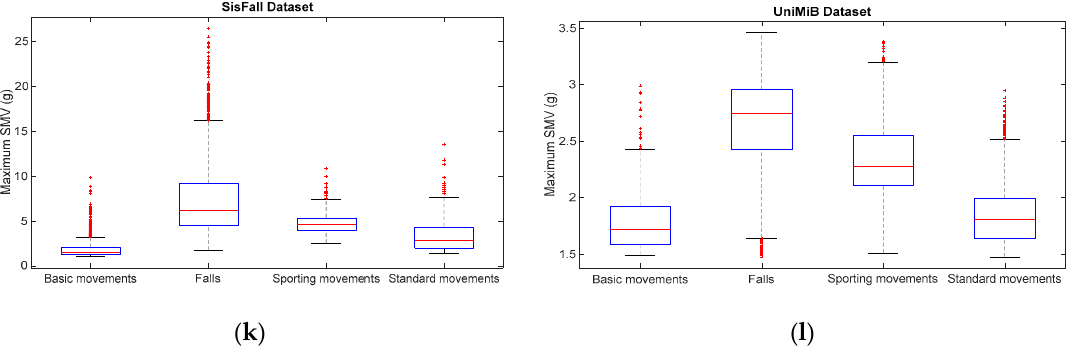
Figure 5. Boxplots of the of the maximum acceleration module for the falls and the three considered categories of ADL (for all the datasets only the acceleration signal at the waist or—if not available—at the thigh is considered). ( a ) DLR Dataset; ( b ) MobiFall Dataset; ( c ) Mobiact Dataset; ( d ) TST Fall Detection Dataset; ( e ) t-Fall Dataset; ( f ) UR Fall Detection Dataset; ( g ) Cogent Labs Dataset; ( h ) Gravity Project Dataset; ( i ) Graz Dataset; ( j ) UMAFall Dataset; ( k ) SisFall Dataset; ( l ) UniMiB SHAR Dataset.